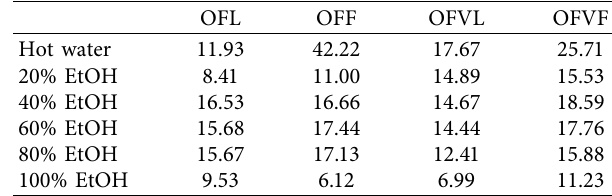
Table 2: Extraction yields of the Osmanthus fragrans leaves (OFL), O. fragrans flowers (OFF), O. fragrans var. aurantiacus leaves (OFVL), and O. fragrans var. aurantiacus flowers (OFVF) ( n � 1).